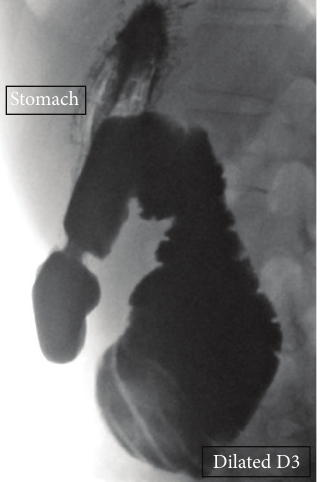
Figure 5: Lateral view of contrast study demonstrating dilated D3.